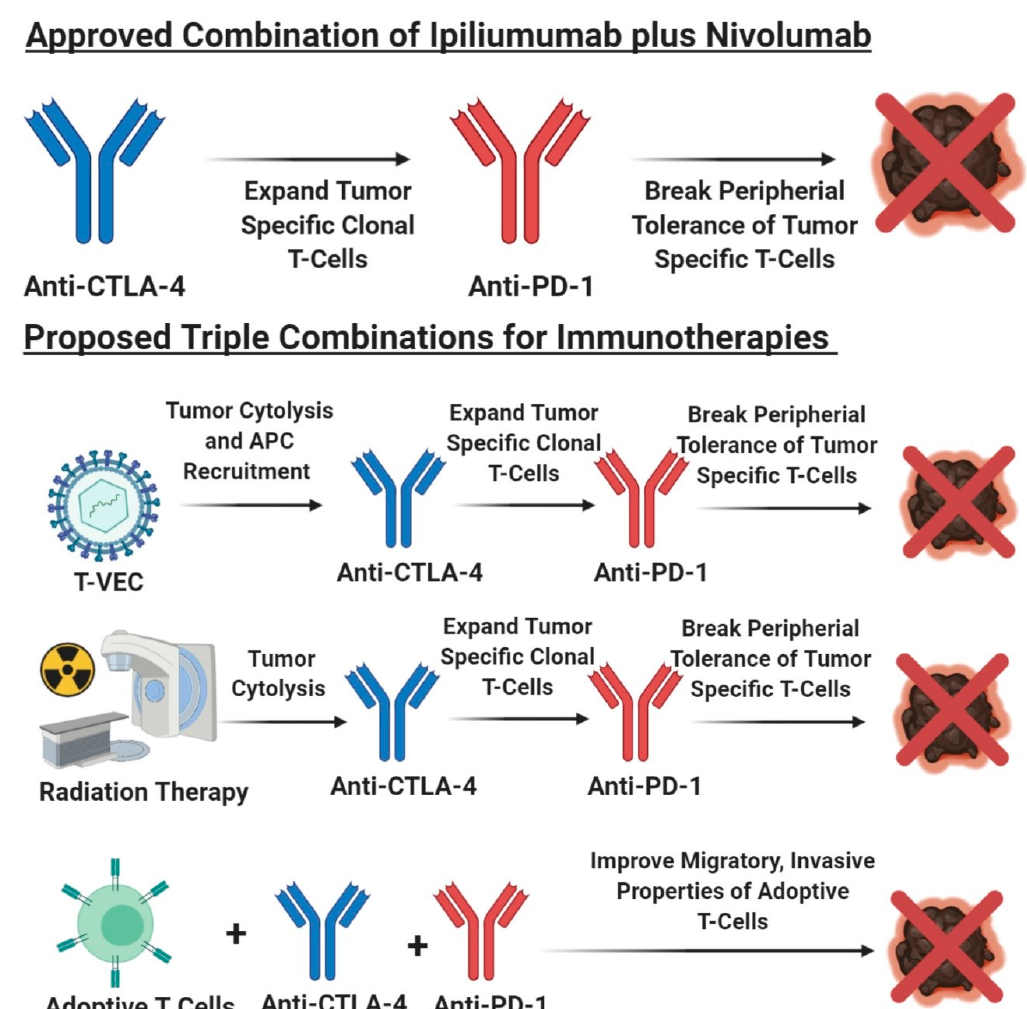
Figure 7. Mechanistic-driven design of combination immunotherapies. Ipilimumab plus nivolumab are approved for the treatment of metastatic melanoma, while the other three are currently under investigation or are proposed in this review. Created with